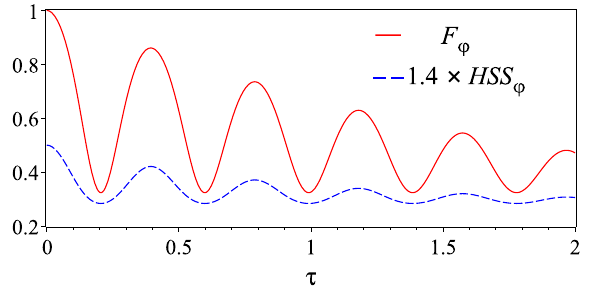
Figure 4. Dynamics of quantum Fisher information F ϕ ( t ) (red solid line) and Hilbert–Schmidt speed HSS ϕ ( t ) (amplified by 1.4 times for comparison, blue dashed line), as a function of the dimensionless time τ for the two-qubits system coupled to a common reservoir, with r 1 oscillates between 0.3 and 1 due to the special choice of the initial